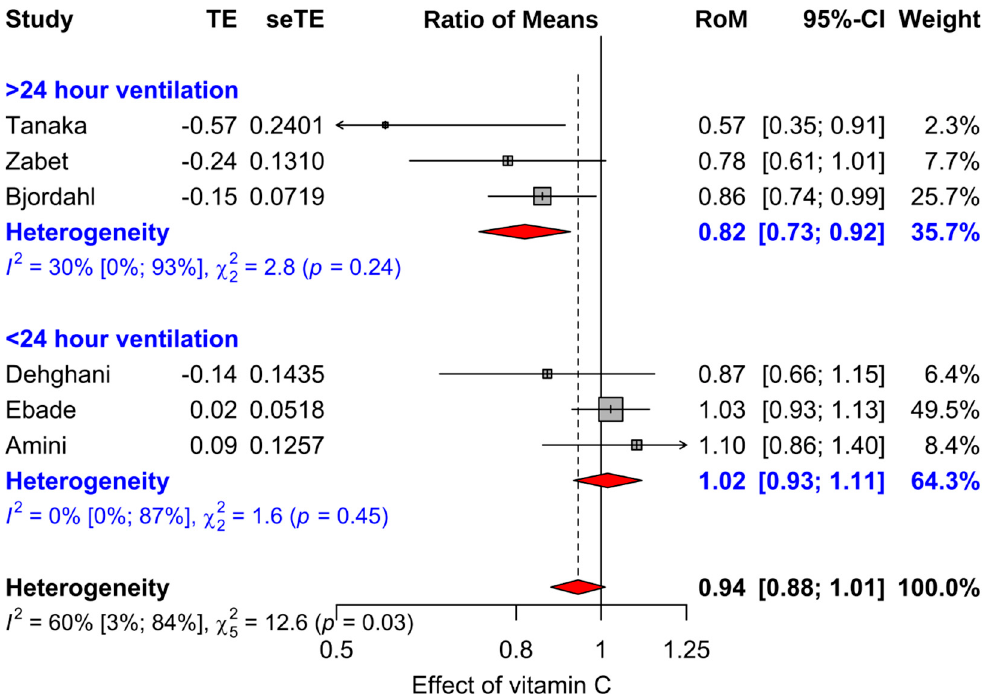
Figure 4. The effect of vitamin C supplementation on the length of mechanical ventilation. The two subgroups are formed by the duration of mechanical ventilation in the control group, see Table 1. The modification of vitamin C effect on the duration of mechanical ventilation was also analyzed by meta-regression over the control group duration of ventilation, and significant modification was found ( p = 0.0013), see Supplementary file S1. The horizontal lines indicate the 95% CI for the vitamin C effect and the squares in the middle of the horizontal lines indicate the point estimate of the effect in the particular trial. The diamond shape indicates the pooled effect and its 95% CI. The reference numbers to the trials are shown in Table 1. Abbreviations: RoM, ratio of means; TE, logarithm of RoM; seTE, the standard error of TE; see ref. [127].